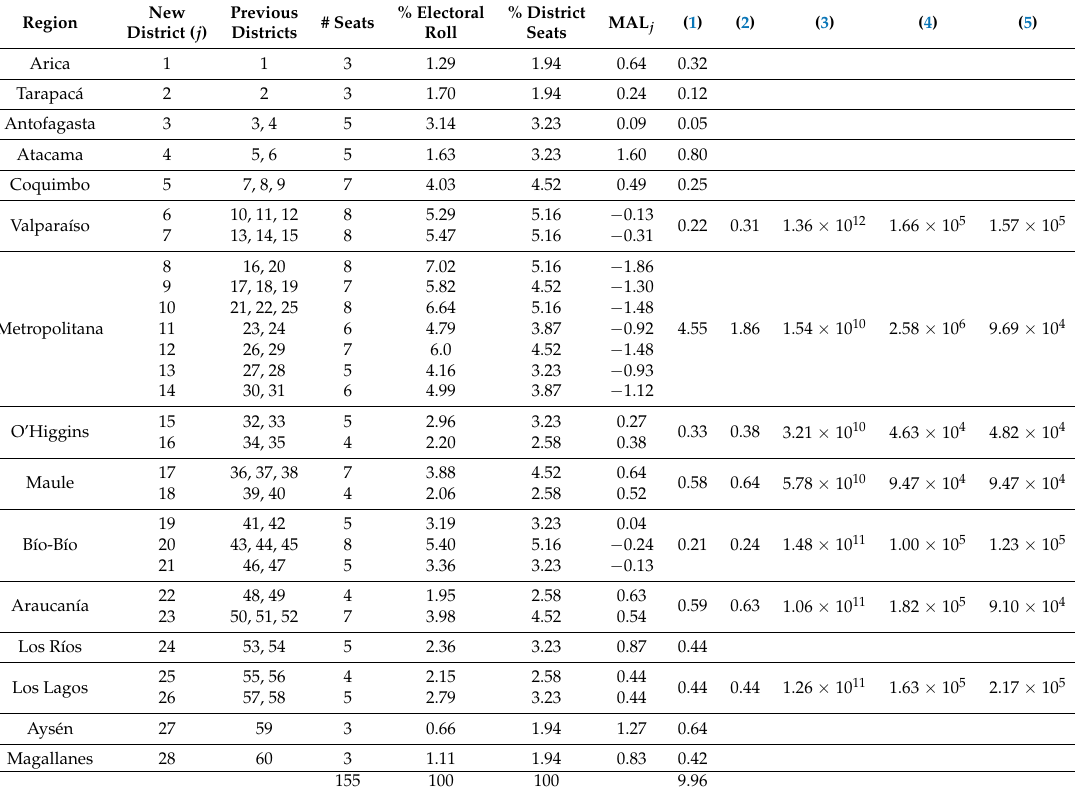
Table 2. Summary of the Chamber of Deputies electoral system defined in the 2015 reform.